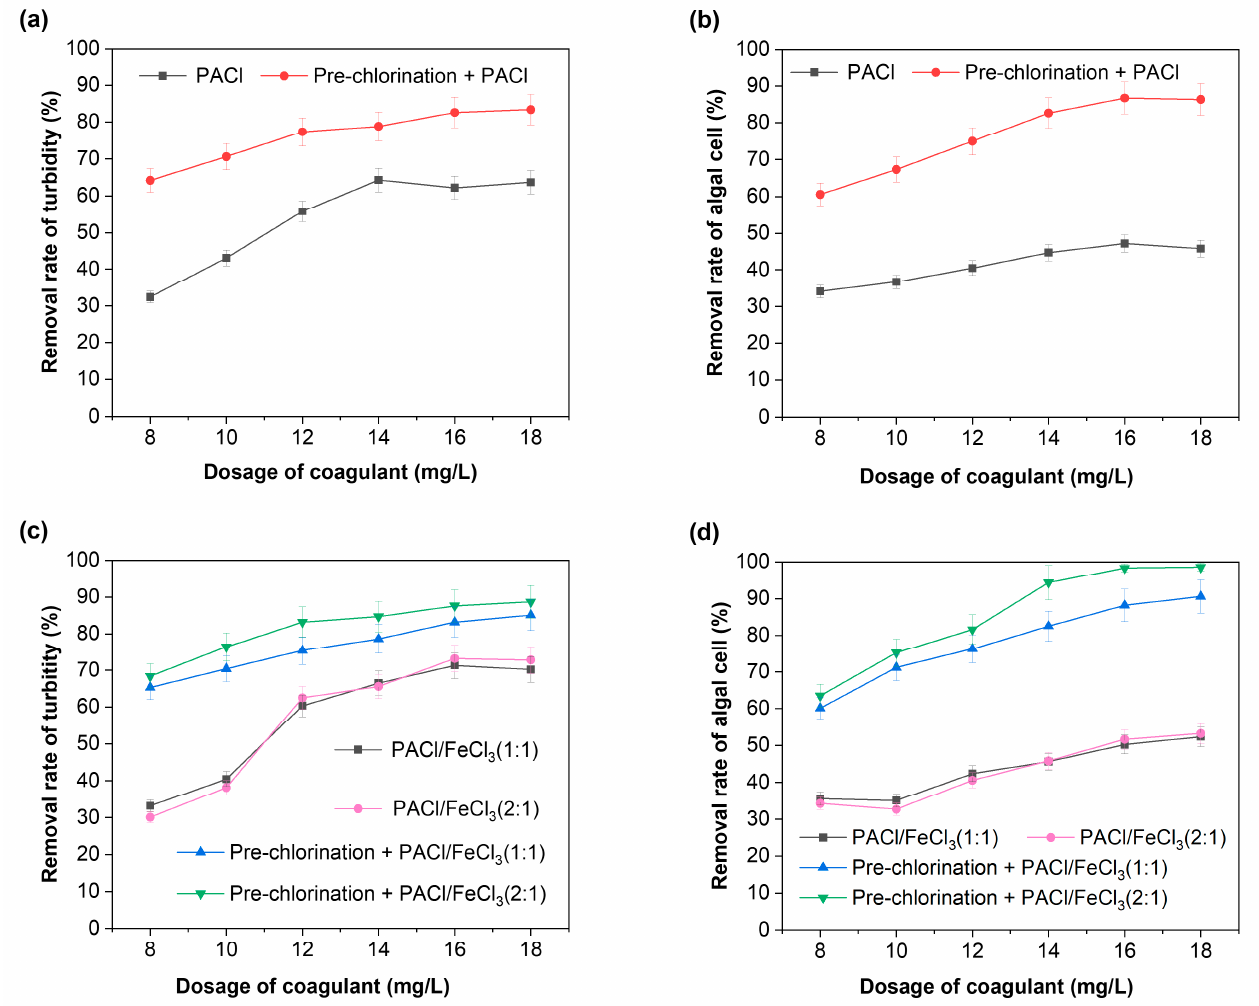
Figure 3. ( a ) Impact of the dosage of PACl on turbidity removal rates with or without pre-chlorination; ( b ) impact of the dosage of PACl on algal cell removal rates with or without pre-chlorination; ( c ) impact of the dosage and ratio of PACl and FeCl 3 on turbidity removal rates with or without pre-chlorination; and ( d ) impact of the dosage and ratio of PACl and FeCl 3 on algal cell removal rates with or without